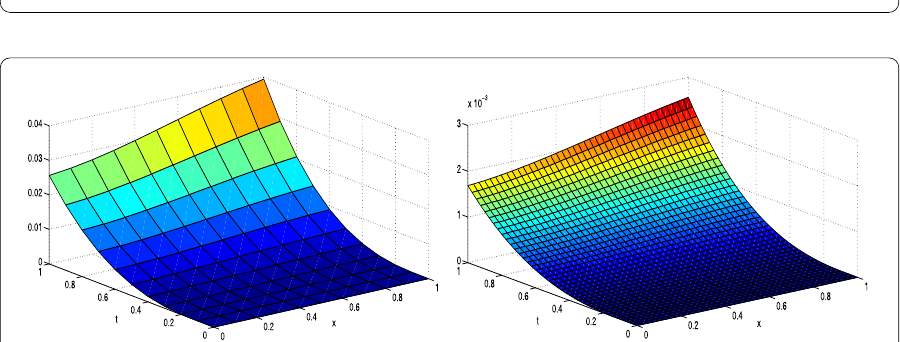
Figure 2 The error surface figures with h = τ = 1